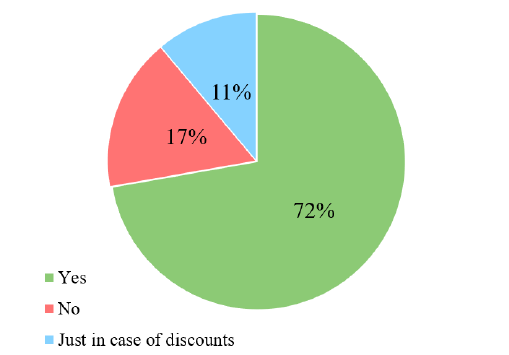
Fig. 6. Question: “Would you be willing to share your data with research institutes and